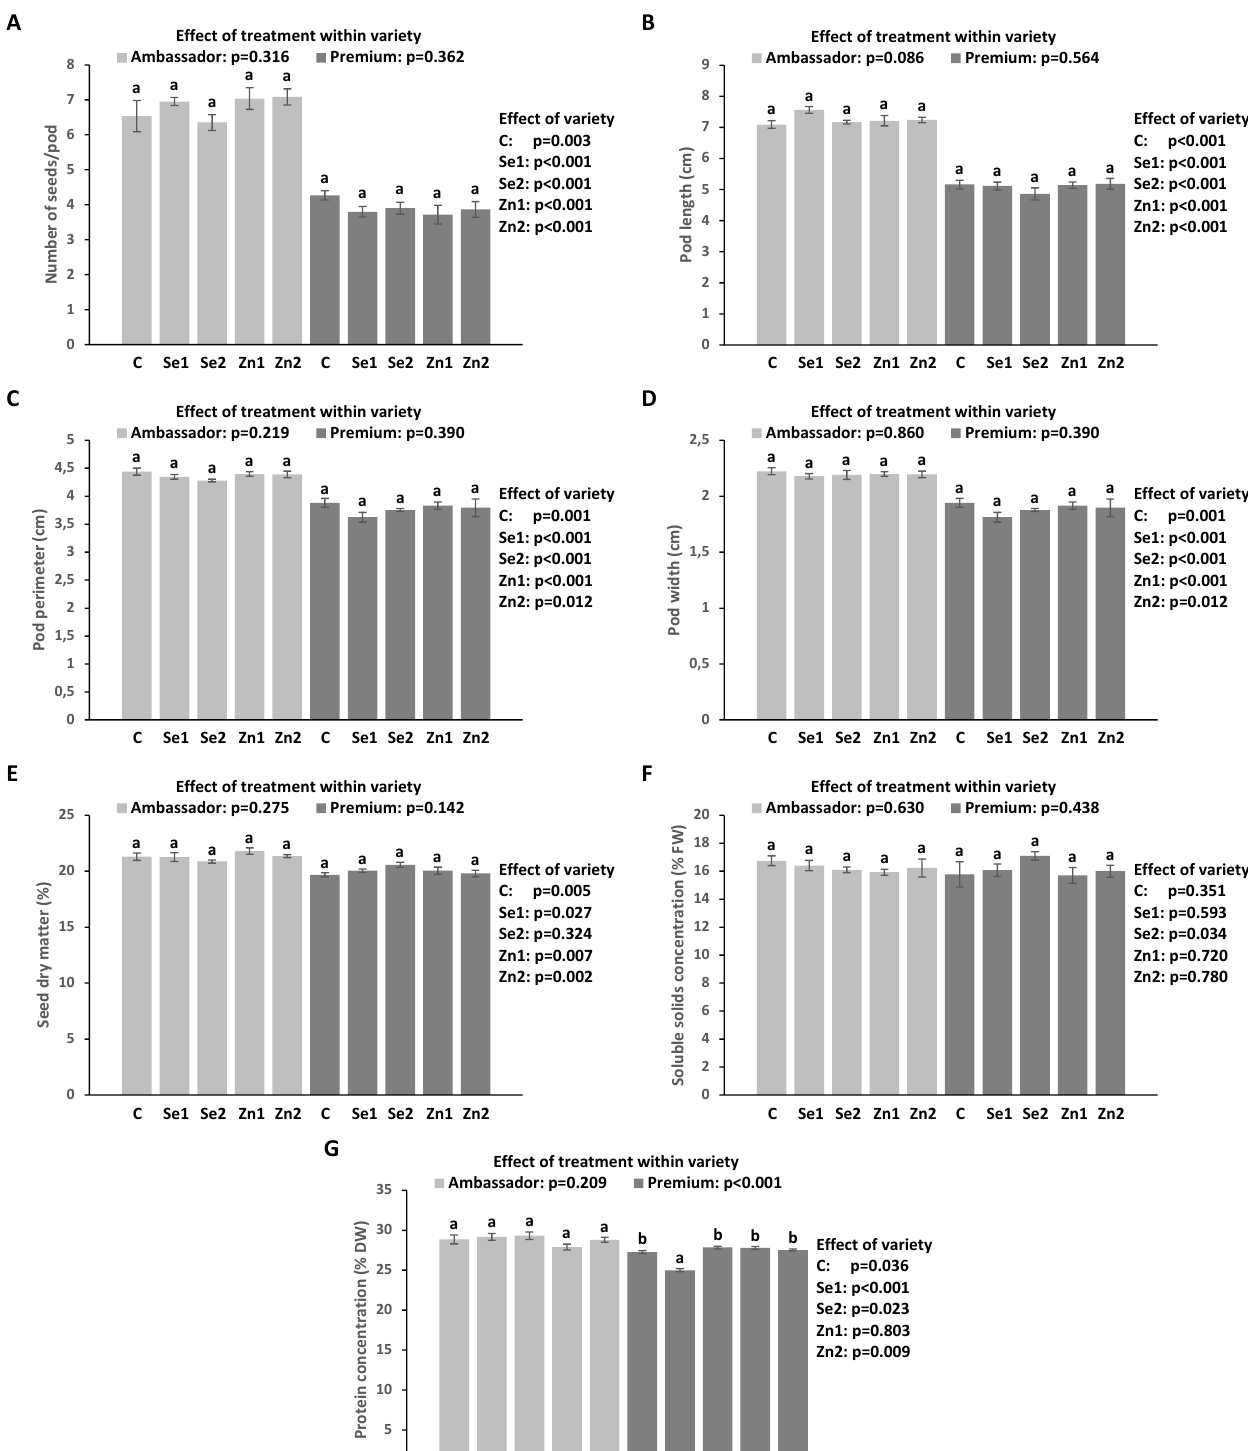
Figure 1. Impact of foliar Se and Zn treatments and variety on the number of seeds/pod ( A ), pod length ( B ), pod perimeter ( C ), pod width ( D ), seed dry matter ( E ), and concentrations of soluble solids ( F ) and protein ( G ) in seeds. C (control): no applied Se and Zn; Se1: 50 g; Se2: 100 g; Zn1: 375 g; Zn2: 750 g; all per ha; mean ± SD; n = 4 replicates. Bars without identical lower letters differed significantly within variety. p -values given on the right part of the graph indicate the impact of treatment across varieties (Ambassador compared to